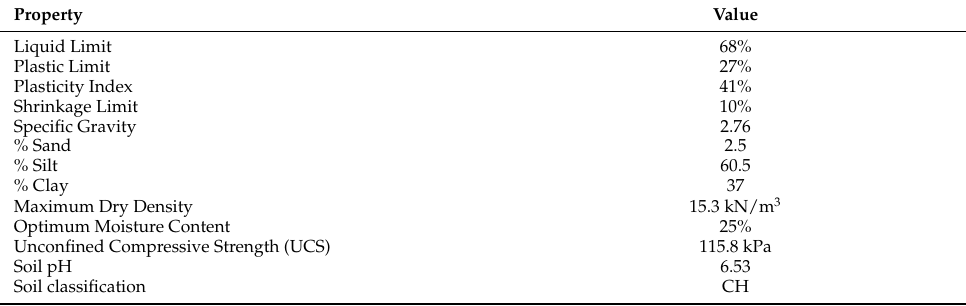
Table 1. Properties of the Virgin Expansive Soil